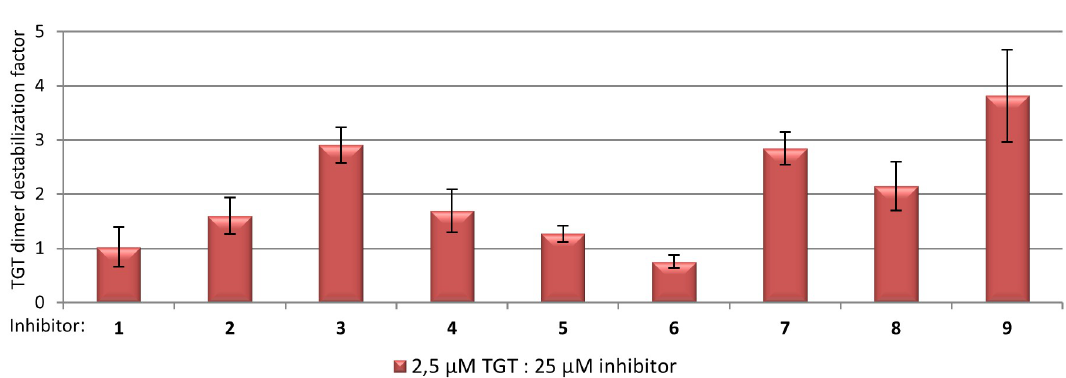
Fig 8. Native MS characterization of TGT dimer disturbing potential from each ligand. Relativequantification of TGT monomers and dimers signalswas performed in the absence(TGT 2.5 μ M)or presence of each ligand(TGT:ligand 1:10 mixture). TGT monomerratios (%) deducedfrom each ligandmixture (S7 Fig; S1 Table) were normalized with respect to the apo-condition, enablingto rank inhibitorsaccordingto their destabilization factor. Corresponding means and standard deviations (black error bars) are derived from triplicate